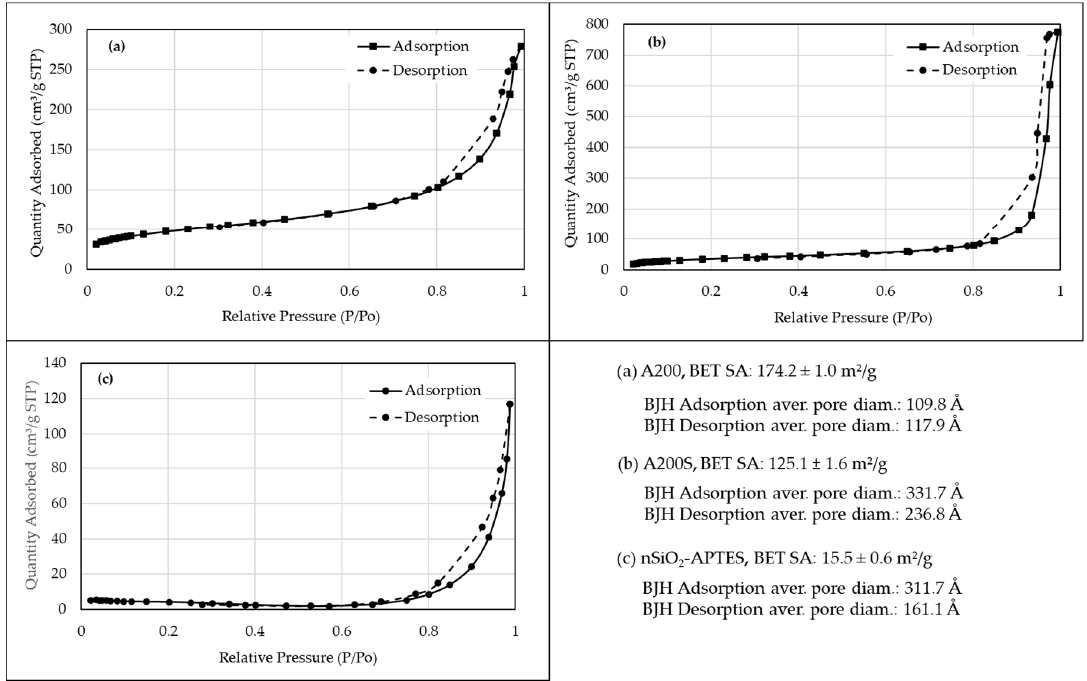
Figure 13. Sorption isotherms of N 2 on ( a ) A200, ( b ) A200S and ( c ) nSiO 2 -APTES NPs at 77 K.